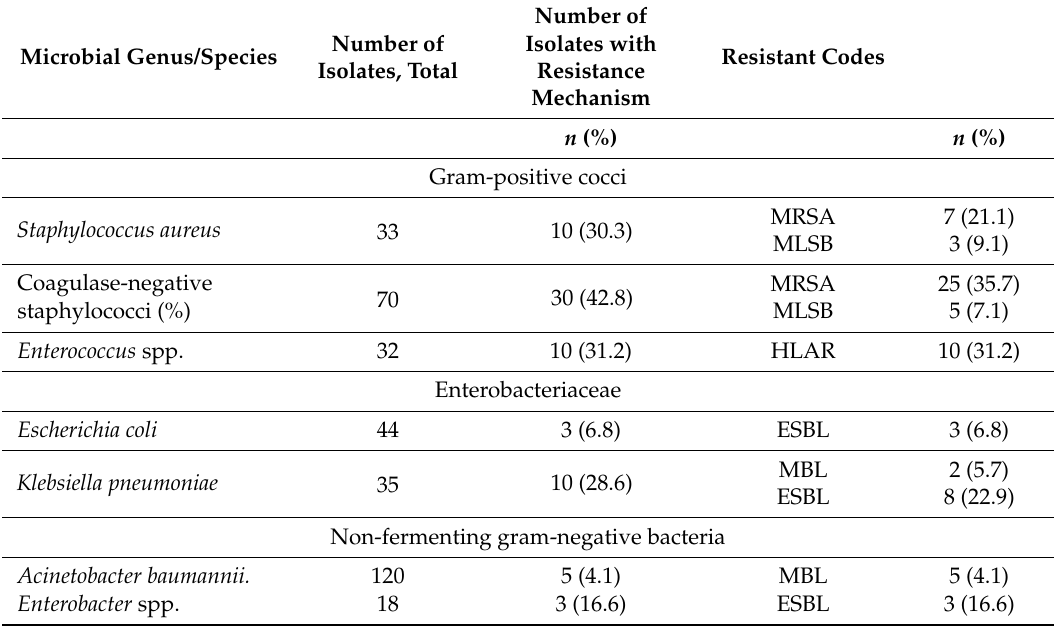
Table 5. Antimicrobial resistance in HAI in the ICU, 2007–2016.